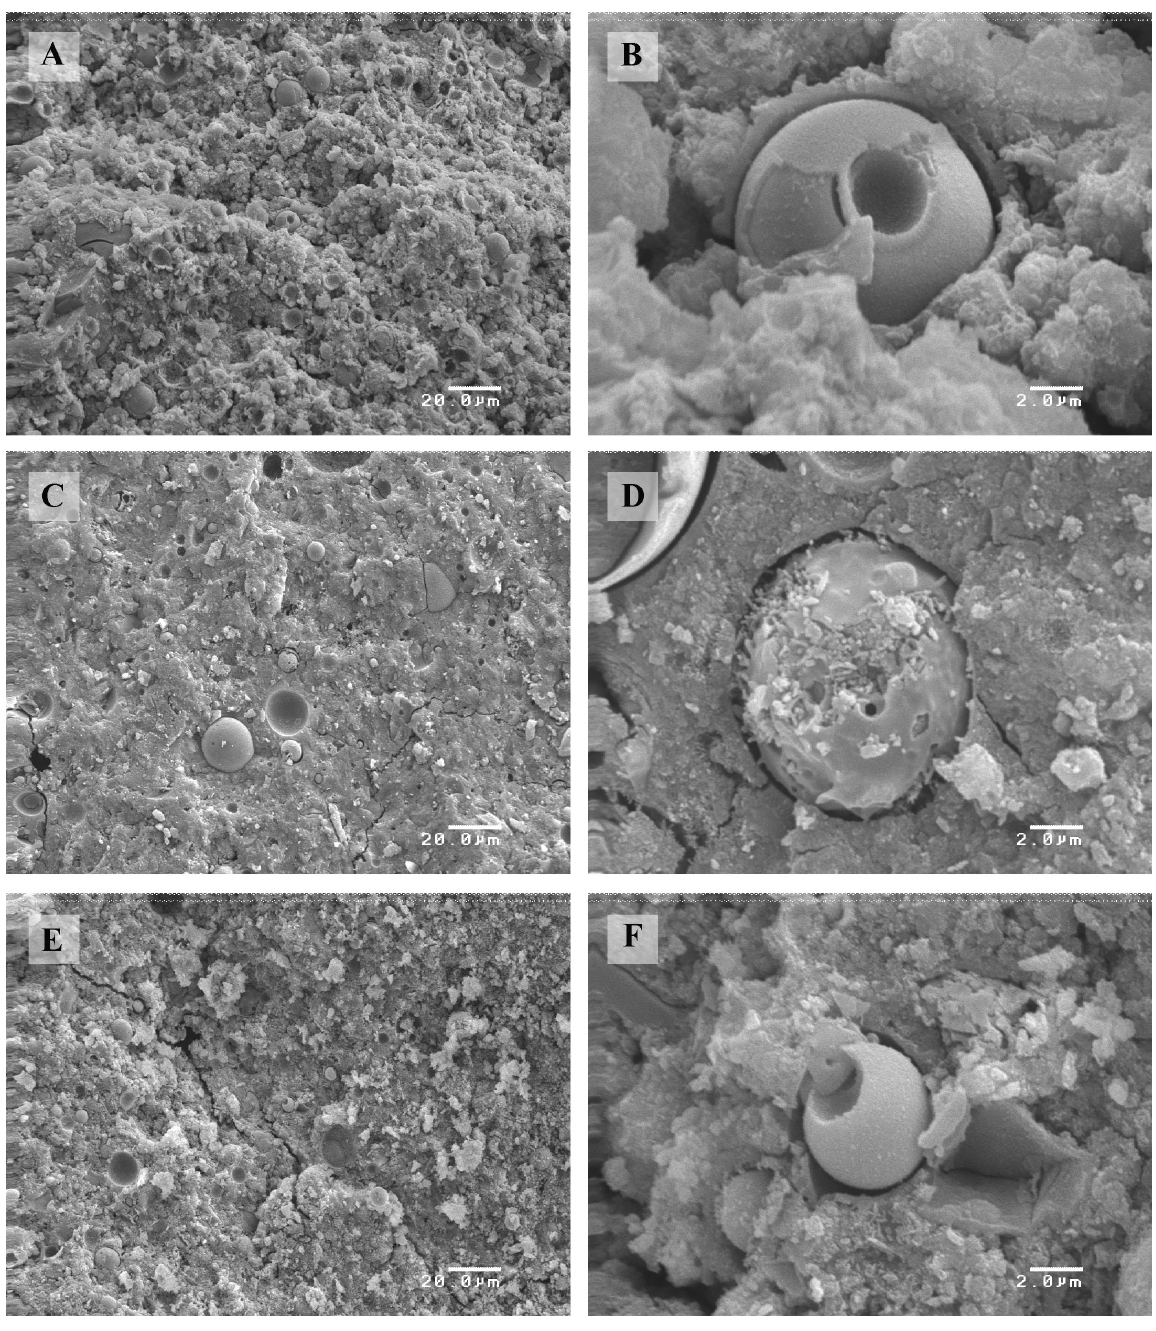
Figure 5: High and low magnification SEM micrographs of the raw fly ash (A, B), attrition milled (C,D) and vibration milled (E, F) fly ash based